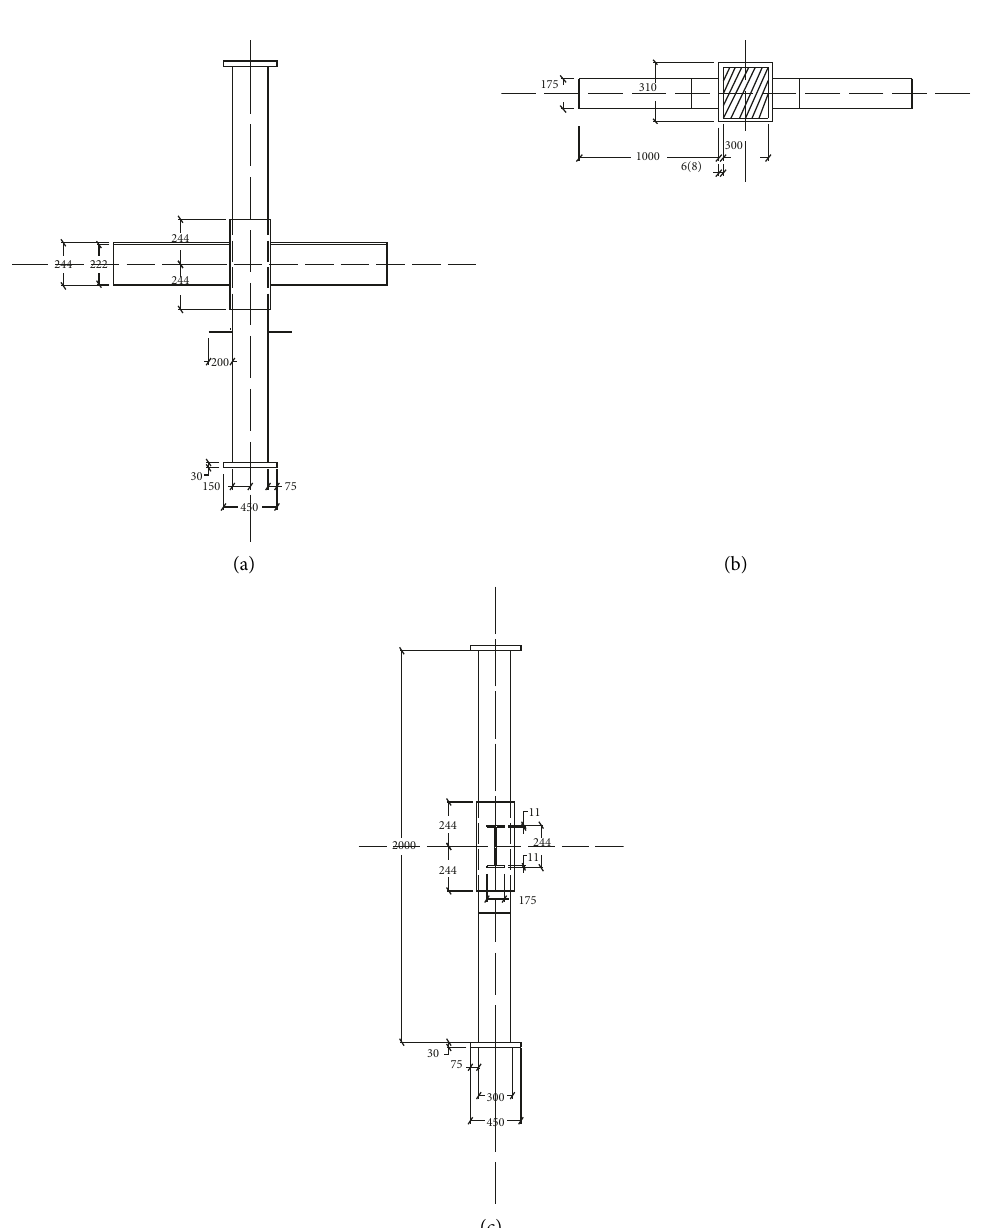
Figure 3: Detailed joint structure. (a) Elevation, (b) plan, and (c)